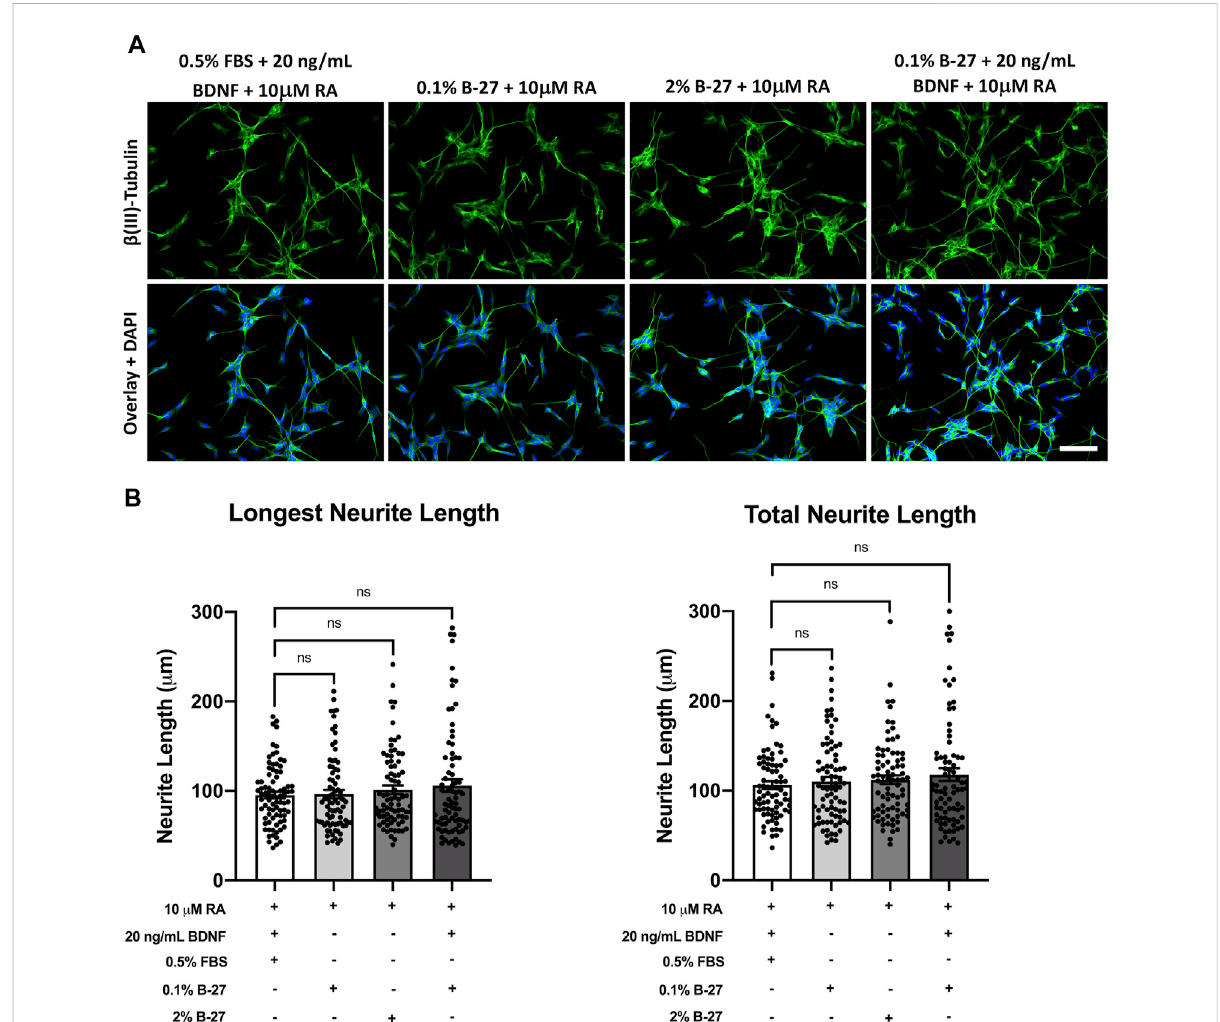
FIGURE 7 SH-SY5Y cells differentiated with B-27 show no signi fi cant difference in neurite length compared with SH-SY5Y cells differentiated with BDNF. (A) SH-SY5Y cells were differentiated for 5 days with DMEM/F-12 + 10 μ M RA, in conjunction with varying combinations of neurite outgrowth- stimulating molecules (B-27 or BDNF) or serum starvation (0.5% FBS). Cells were fi xed with 4% PFA for 20 min. Microtubules were stained with 1: 500 mouse anti- β (III)-Tubulin ( R&D Systems , #MAB1195) and visualized with 1:400 Alexa Fluor ® 488-conjugated donkey anti-mouse ( Thermo Scienti fi c , #A21202) (green). Nuclei were counterstained with 1:5,000 DAPI (blue). Images taken at ×20 magni fi cation. Scale bar = 100 μ m. (B) Longest neurite length and total neurite length measurements were taken using the FIJI software (Schindelin et al., 2012). Three independent experimental replicates were performed and 80 cells per condition were measured in total. Data presented as mean ± SEM. Statistical signi fi cance against the DMEM/F-12 + 10% FBS condition was determined using ordinary one-way ANOVA and Tukey ’ s multiple comparison tests in